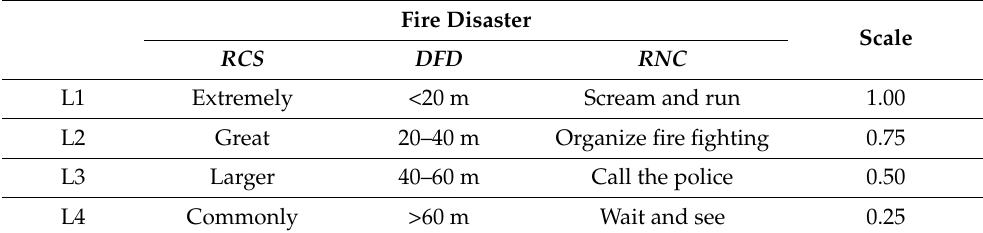
Table 1. Standardization of Risk.